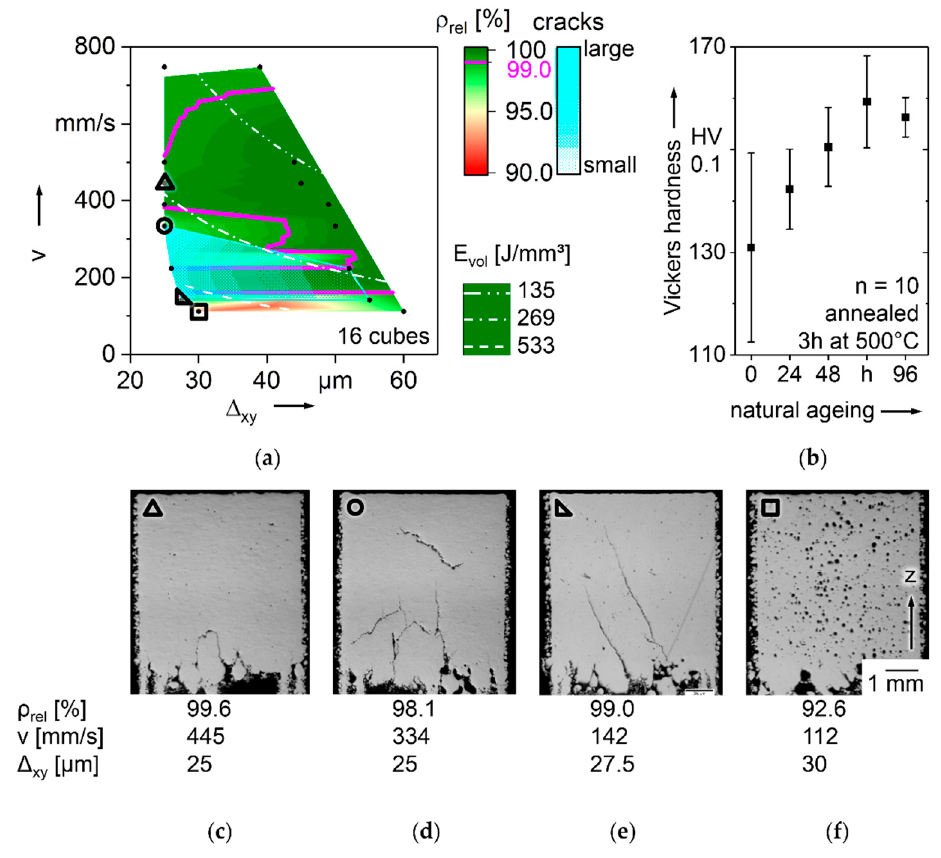
Figure 13. LBM process map of Al-Cu-Mg-Ti powder mixture, all particles < 20 µm; ( a ) ρ rel over v and ∆ xy , E vol isolines in white, pink line ρ rel = 99%, light blue marks crack tendency; ( b ) hardness development during natural ageing of a sample built with parameter as in ( c ); ( c ) sample with few, small cracks connected to the bottom surface; ( d ) sample with many cracks throughout volume; ( e ) sample with many, large cracks throughout volume; ( f ) sample with many, spherical gas pores.